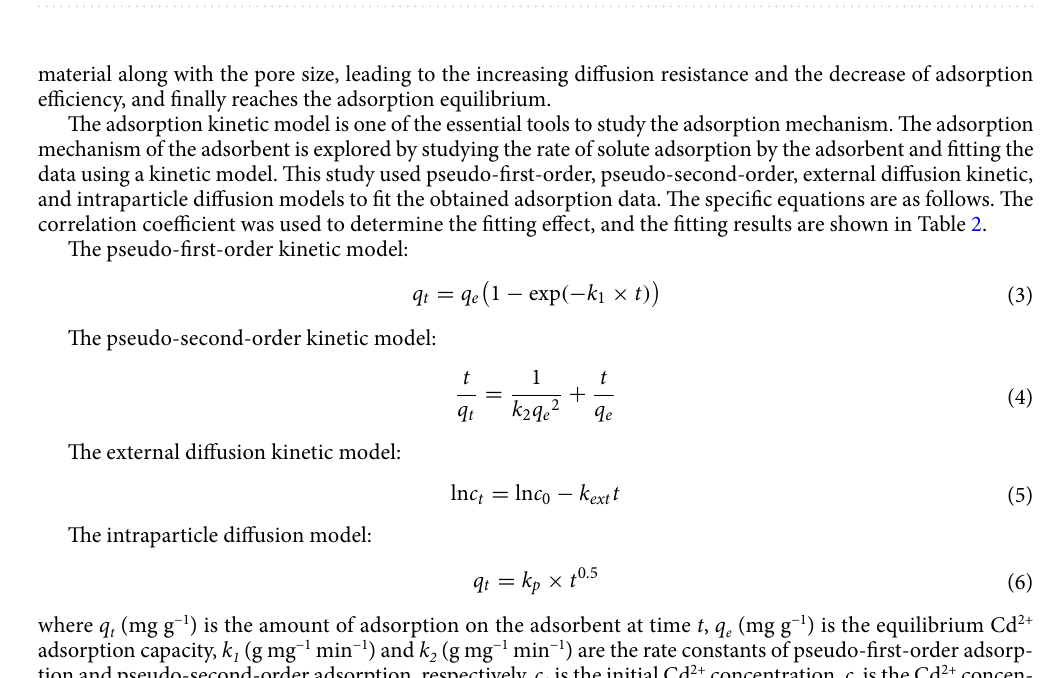
Table 2. Fitting parameters for the adsorption kinetic